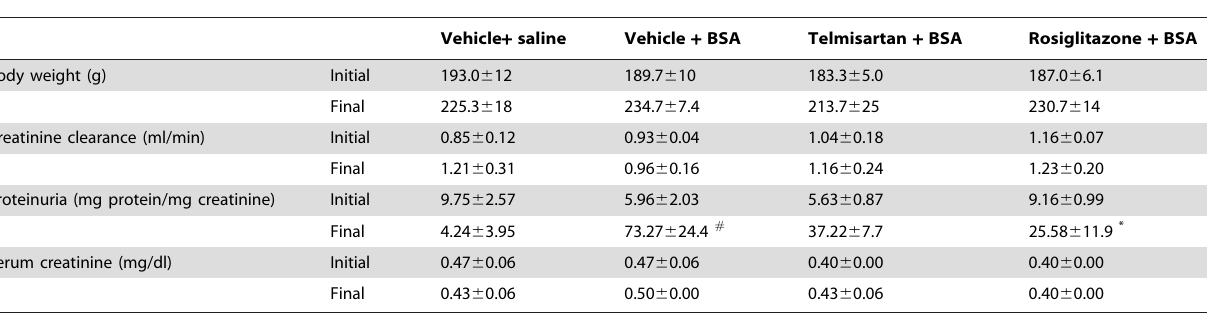
Table 1. Physiological data of BSA injected rats.